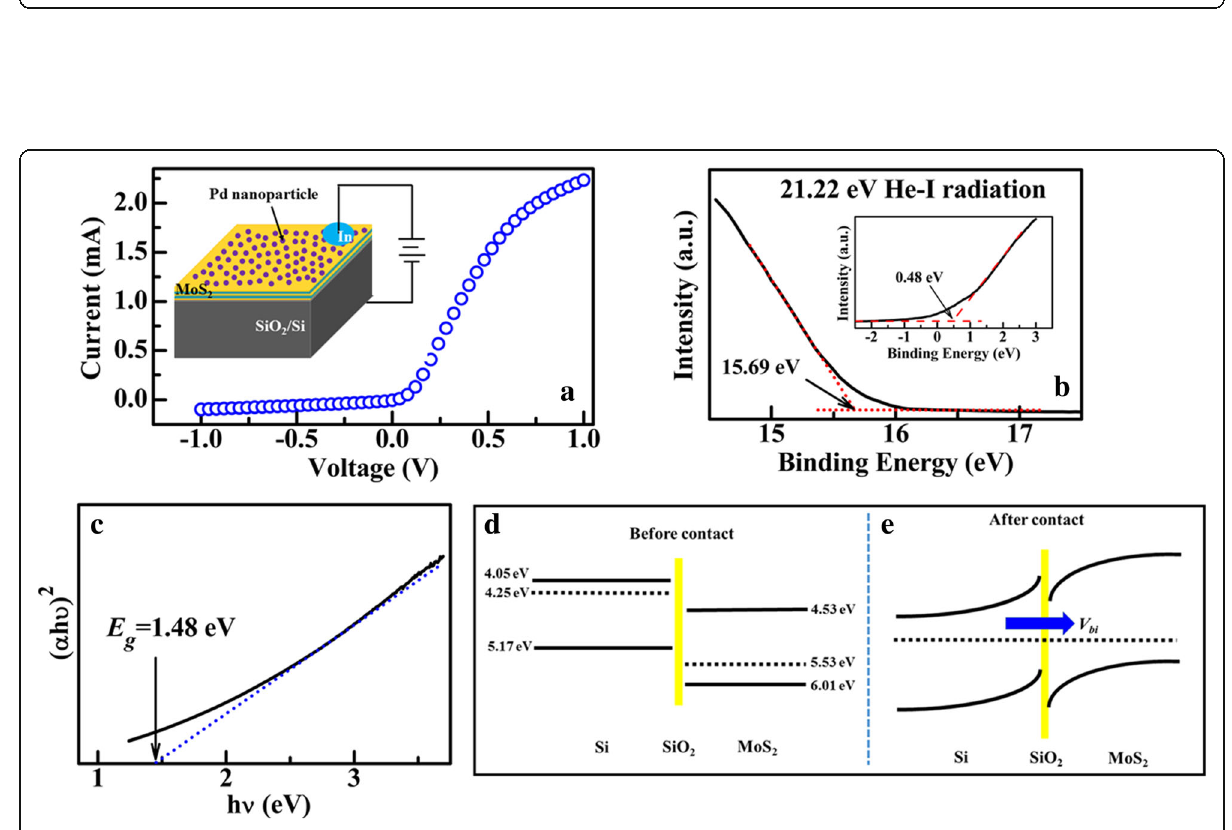
Fig. 3 Resistivity-temperature curve of different samples grown on 300-nm SiO 2 /Si substrate. a Few-layer MoS 2 . The inset shows the schematic illustration for the measurements. b 5-nm Pd layer. The inset shows the ρ - T curve for the 10-nm Pd layer. c 5-nm Pd-decorated MoS 2 layers. d Resistivity of the Pd-decorated MoS 2 layers as a function of Pd